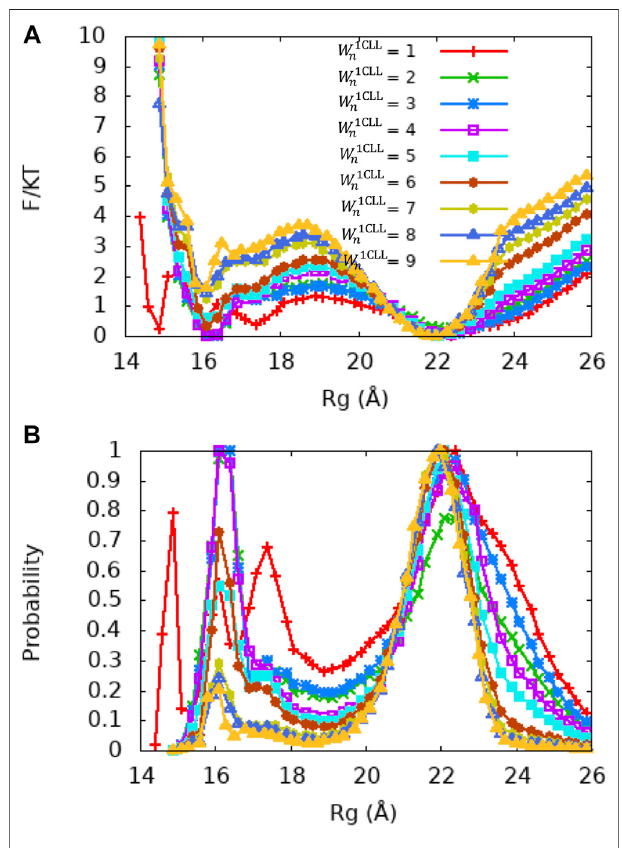
FIGURE 5 | PMF and Rg distribution of the Ca 2+ -CaM models for different values of the local memory weight W 1CLL n